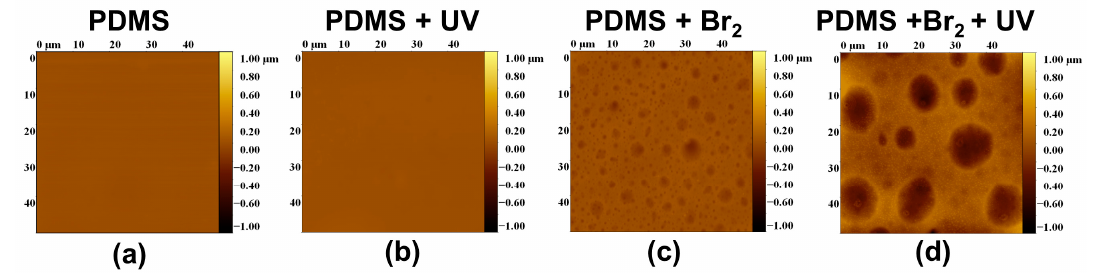
Figure 8. Examples of 2D AFM profiles: ( a ) Sample of pristine PDMS. ( b ) UV-irradiated sample. ( c ) Sample exposed to Br 2 (g), but not irradiated. ( d ) Sample exposed to Br 2 (g) followed by UV-irradiation.